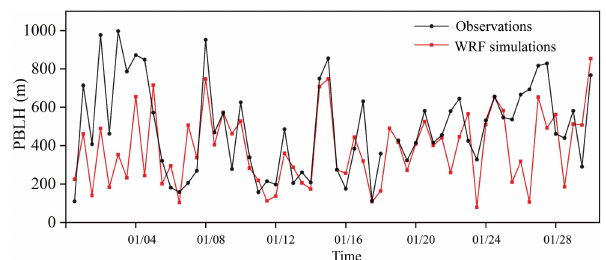
Figure A1. Time series of the observed (black) and simulated (red) PBLH at 08:00 and 20:00 Beijing time (BJT) at the Zhengzhou sounding